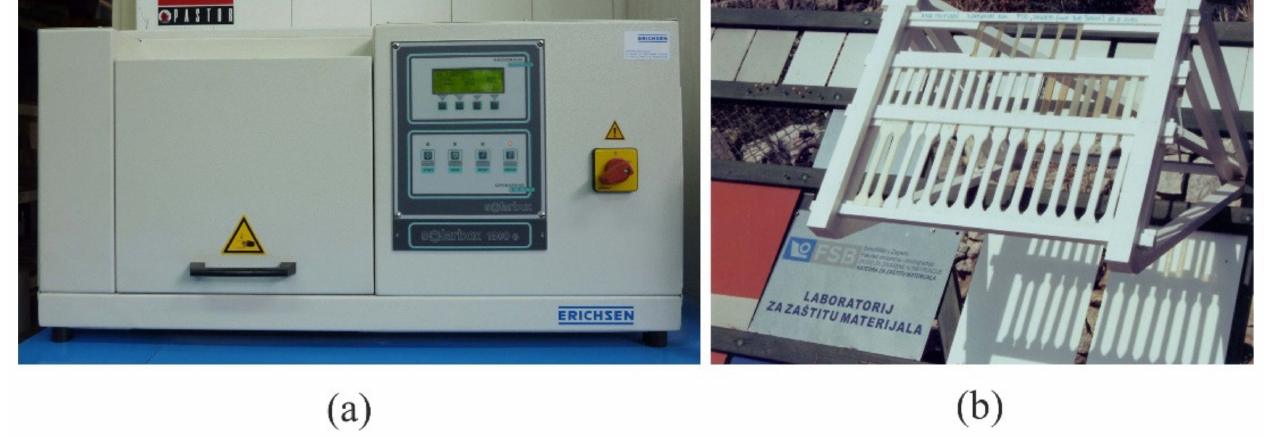
Figure 4. Chamber for testing of exposure to sources of light and field tests for the influence of atmospheric conditions: ( a ) chamber for laboratory exposure to weathering condition, ( b ) natural exposure to weather condition, location island Murter,